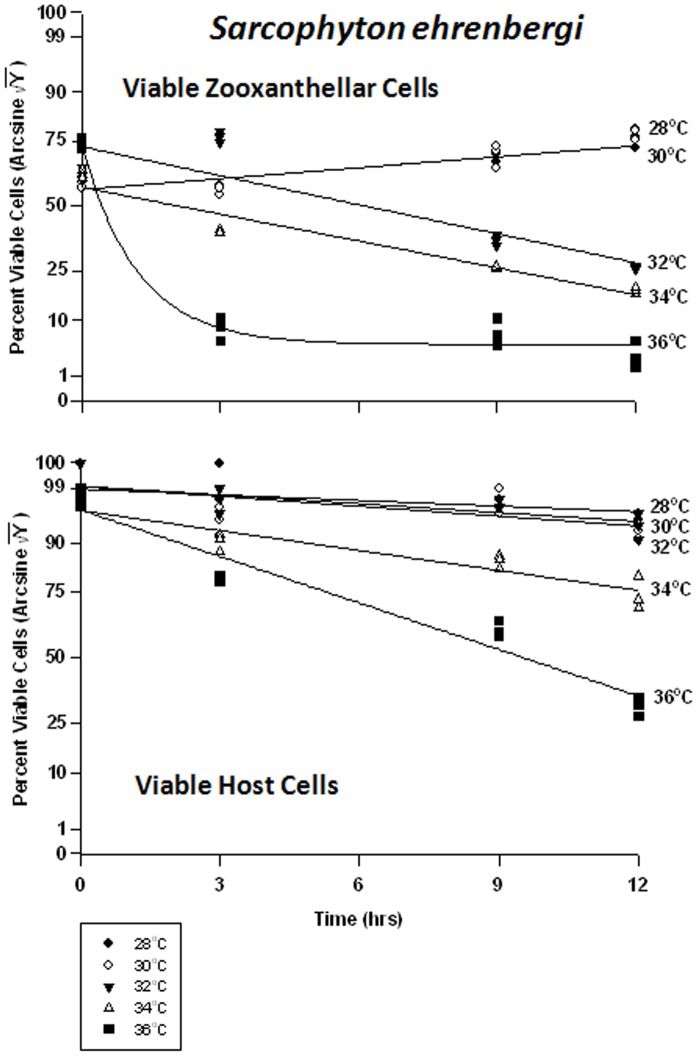
Effects of increasing seawater temperature on percent viable endosymbiotic Symbiodinium and host coral Sarcophyton ehrenbergi cells.
In-hospite, collected over a12 h period. Data shown here relate to corals exposed to 28 to 36°C. • = 28°C; ○ = 30°C;▾ = 32°C; Δ = 34°C; ▪ = 36°C. Data transformed by arcsine for normalization purposes. Each point represents the percentage (%) of different cell types analyzed via TEM. Tissues sampled at 3-hr intervals. (a) Zooxanthellae: Significant linear regression in zooxanthellar cells at 28°C and 34°C (p<0.05); Y = 0.843X +49.184, and Y = −2.072+49.688, respectively. Linear trends shown for 30 and 32°C to facilitate comparison (Y = 1.020X +48.679, and Y = −2.243X +59.107, respectively); significant non-linear components at these temperature responses (p<0.05–0.001). Significant non-linear response at 36°C (p<0.001; Y = 13.285+ −46.506*(1−e[0.838X]). Host Cells: No significant linear or non-linear response at 28°C or 32°C; (slope not significantly different from ‘0′). Significant negative linear response at 34°C (p<0.01; Y = −1.532X +79.187). Significant non-linear components at 30°C and 36°C (p<0.01–0.001); negative linear trends shown into facilitate comparison (Y = −0.762X +84.783, and Y = −3.578X +79.336, respectively).